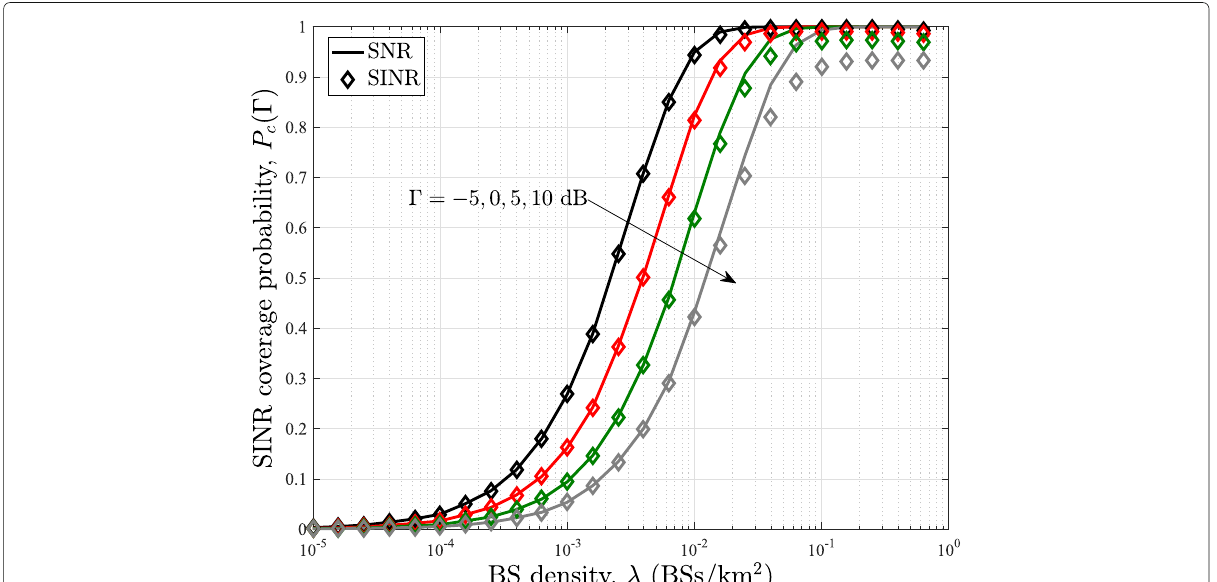
Fig. 11 Comparison of SINR and SNR coverage probability in the uplink of mmWave cellular networks